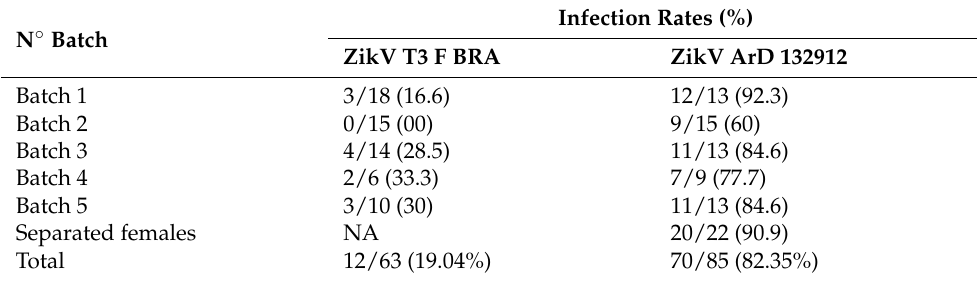
Table 4. Infection rates of females A. aegypti exposed to an infectious blood meal for the study of vertical transmission of ZIKV. Infection Rates (%) N ◦ Batch ZikV T3 F BRA